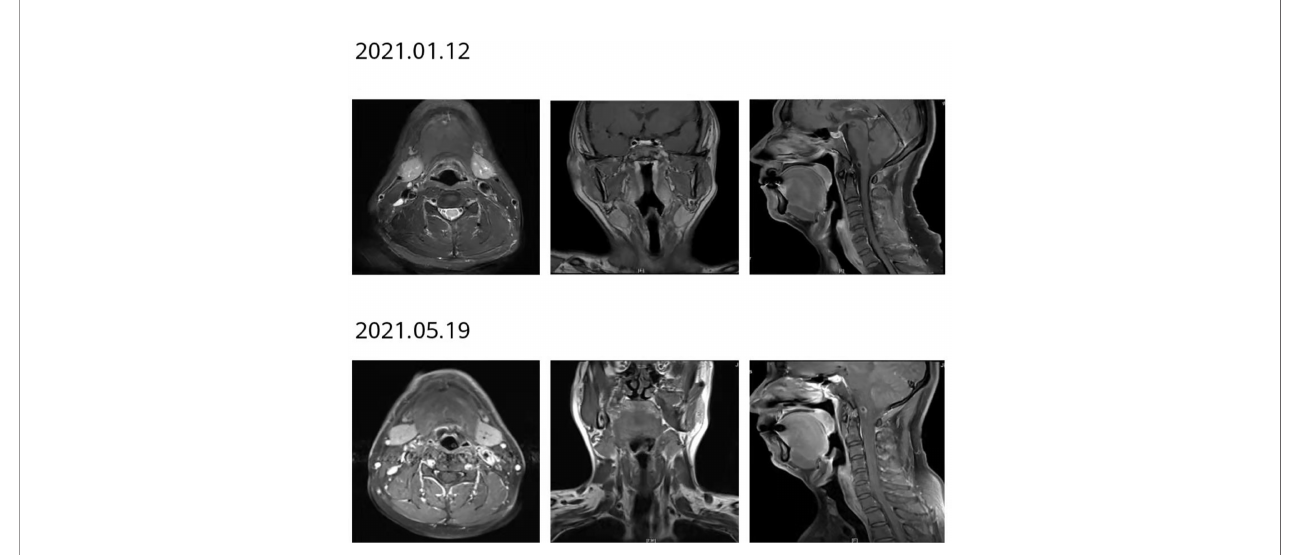
FIGURE 10 | After 12 courses of treatment, no lesions were found in the reexamination of throat MRI. Compared with that after 8 courses of treatment, the curative effect was evaluated as maintaining CR.